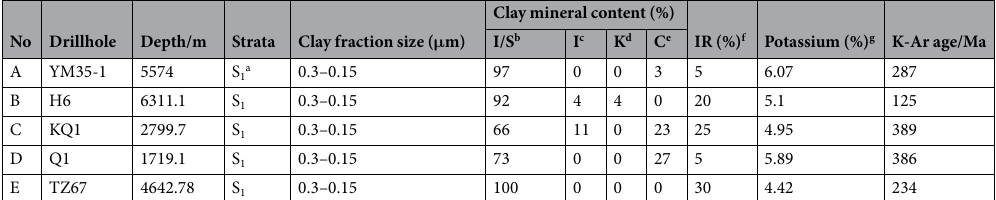
Table 1. Basic information concerning illitic samples in this study of the Tarim Basin. a S denotes Silurian. b I/S denotes mixed layer illite/smectite. c I denotes illite. d K denotes kaolinite. e C denotes chlorite. f IR (%) denotes interstratified ratio, i.e. the percentage of smectite layers in mixed layer illite/smectite. g Potassium (%) denotes K content in the samples. * Clay mineral content, IR values, K content and K-Ar age data for the samples in this study were reported in ref. 13